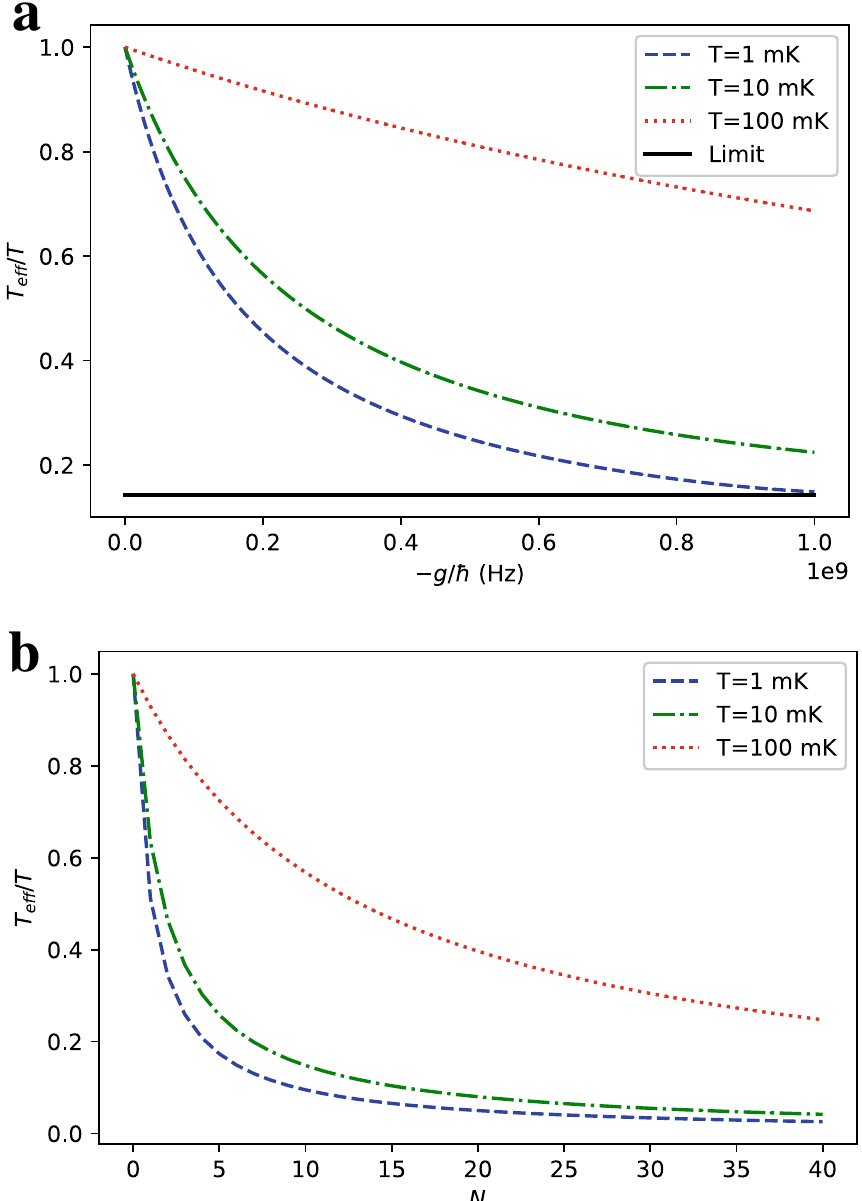
Figure 2. Ratio of the effective T eff temperature of the central qubit to the environment temperature T in a longitudinal ferromagnetic Ising spin-star model with h = 1 GHz for ( a ) N = 6 ancilla qubits at different interaction strengths g , ( b ) g = − h at different number of ancilla qubits N